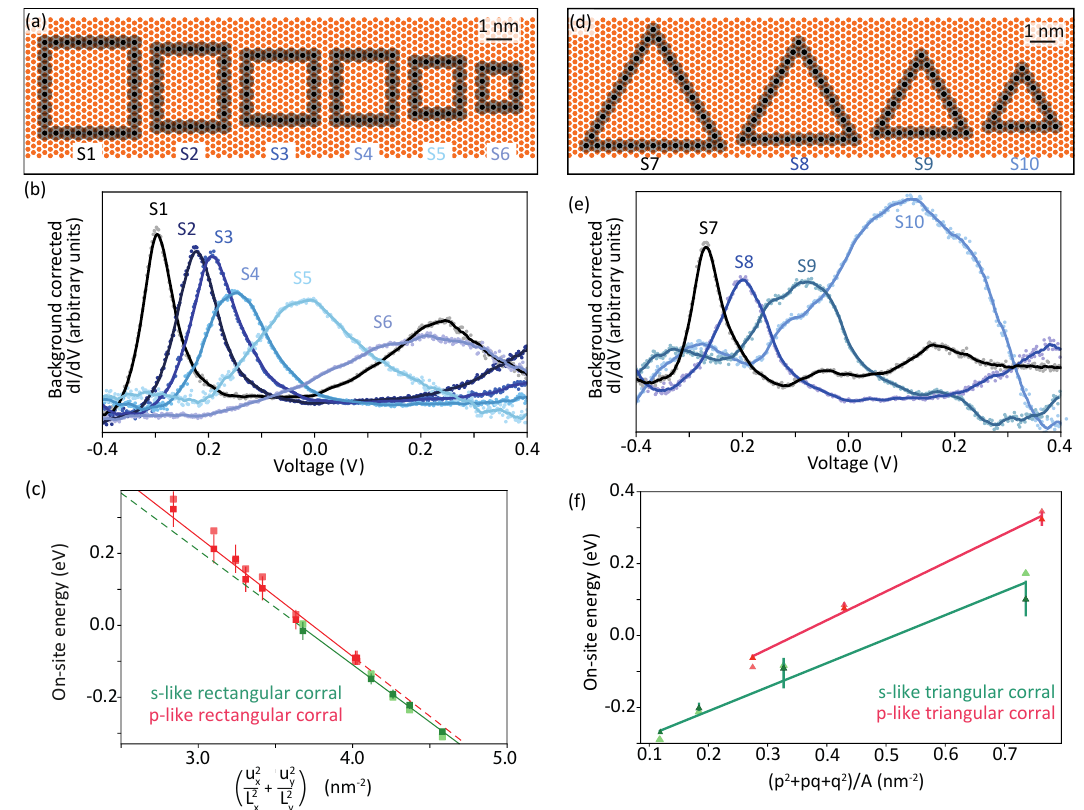
Figure 4: (a) Geometries of the rectangular corrals investigated. (b) dI taken at the centers of the rectangular corrals shown in (a). (c) On-site energy as / L 2 + u 2 / L 2 a function of u 2 . Green and red points represent experimental data n x x n y y for s - and p - like states respectively. Light red and light green points represent the energies calculated using a muffin tin model. Solid lines represent a linear fit to the experimental data. (d)-(f) Same as (a)-(c) but for triangular corrals.